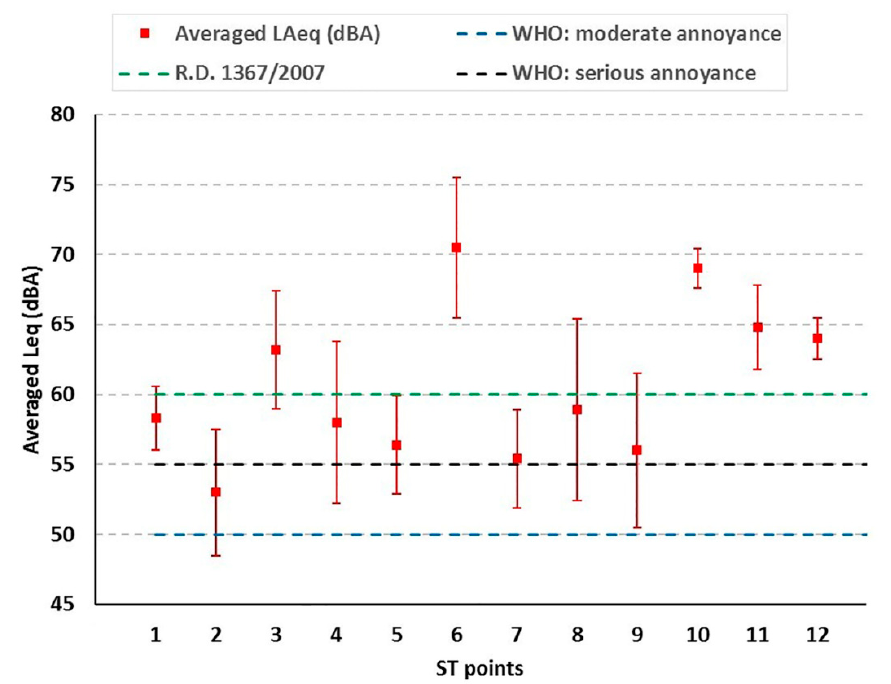
Figure 5. Averaged values of L Aeq for short-term measurements points ST-1 to ST-12 at the University Hospital of Badajoz.